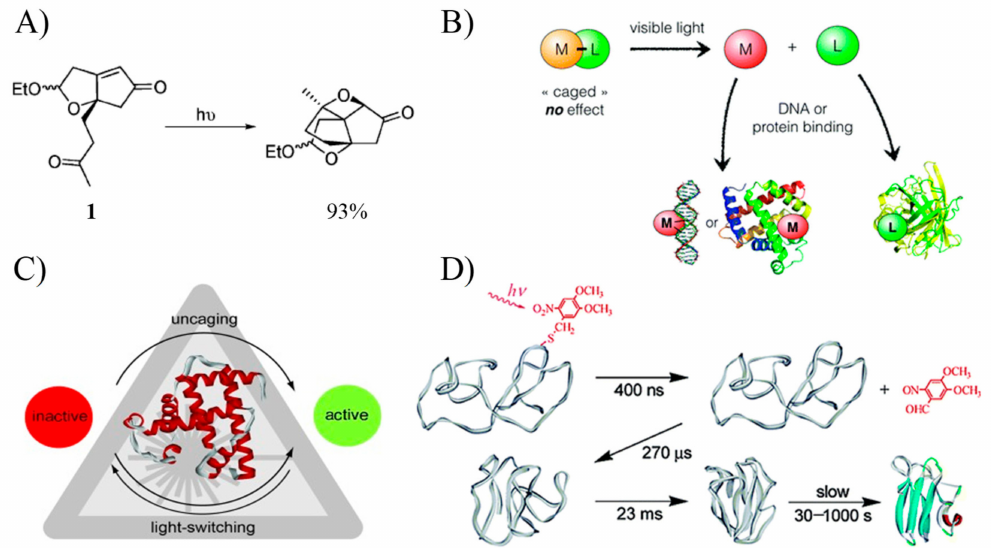
Figure 1. ( A ) An illustration of the use of photochemistry for easy construction of the complex tetracyclic ring of merrilactone A, a potent neurotrophic compound isolated from the pericarps of the Illicium merrillianum plant, starting from compound 1 . ( B ) The principle of photoactivated chemotherapy using a non-toxic metal–ligand (M–L) compound: upon photocleavage of the M–L bond, either the fragment M or L, or both, display toxicity to cancer cells. ( C ) The use of photoresponsive structural cross-linkers allows phototriggering to be employed as a useful method to investigate proteins’ conformational changes. ( D ) The introduction of photolabile motifs enables the investigation of initial protein folding dynamics. Reprinted from [10,14–16] with